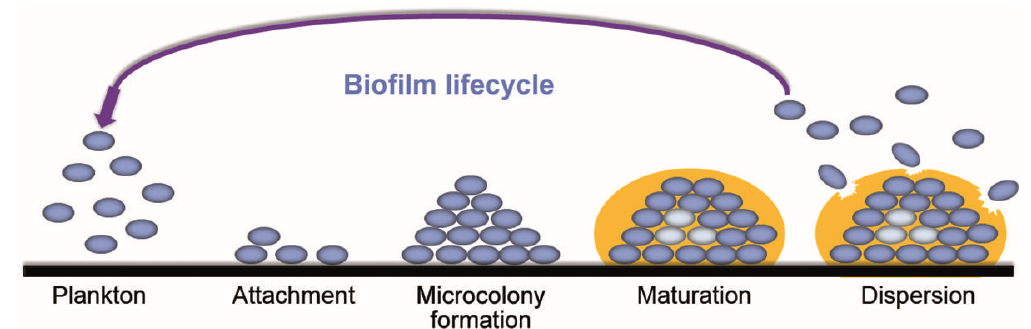
Figure 8. Biofilm development steps produced by microorganisms [36]. Adapted with permission from ref. [36]. A 2014 Creative Commons Attribution (CC BY) license.